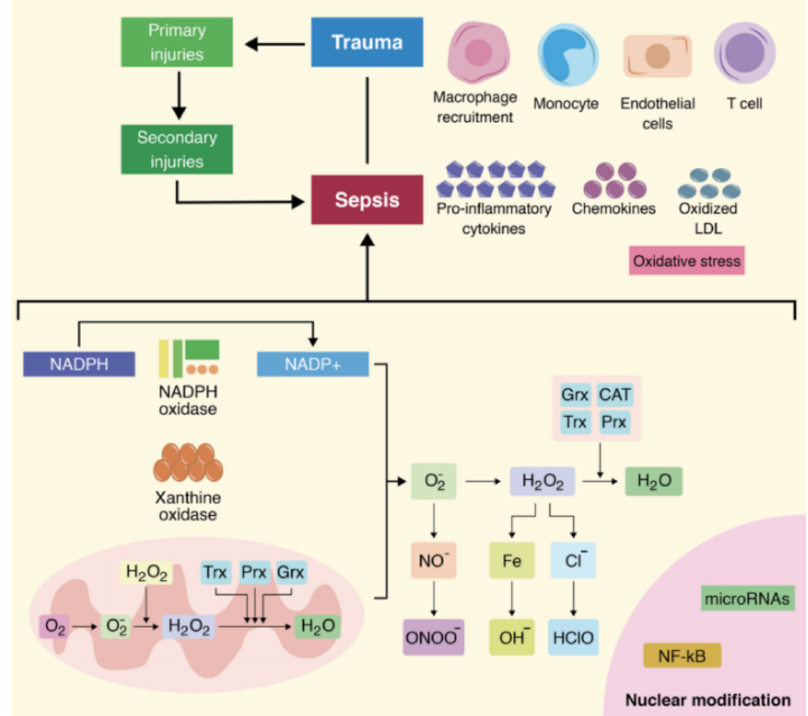
Figure 3. The critically ill polytrauma patient is characterized by a series of secondary, post-traumatic injuries, represented especially by cellular and molecular damage. Oxidative stress is an important molecular phenomenon, and it has important links with a series of bio-macromolecular systems. An important source of free radicals is the mitochondria, where huge amounts of free oxygen radicals are produced that will further lead to the augmentation of the pro-oxidative phenomena. Moreover, the molecular disaster will continue as other systems are affected such as the endovascular system, lipid molecules, proteins, and cellular